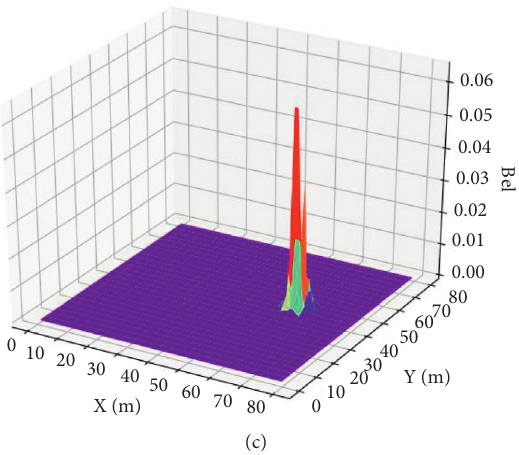
Figure 9: Reliability grid of random driving simulation experiment under noise. (a) k � 0, (b) k � 38, and (c) k �